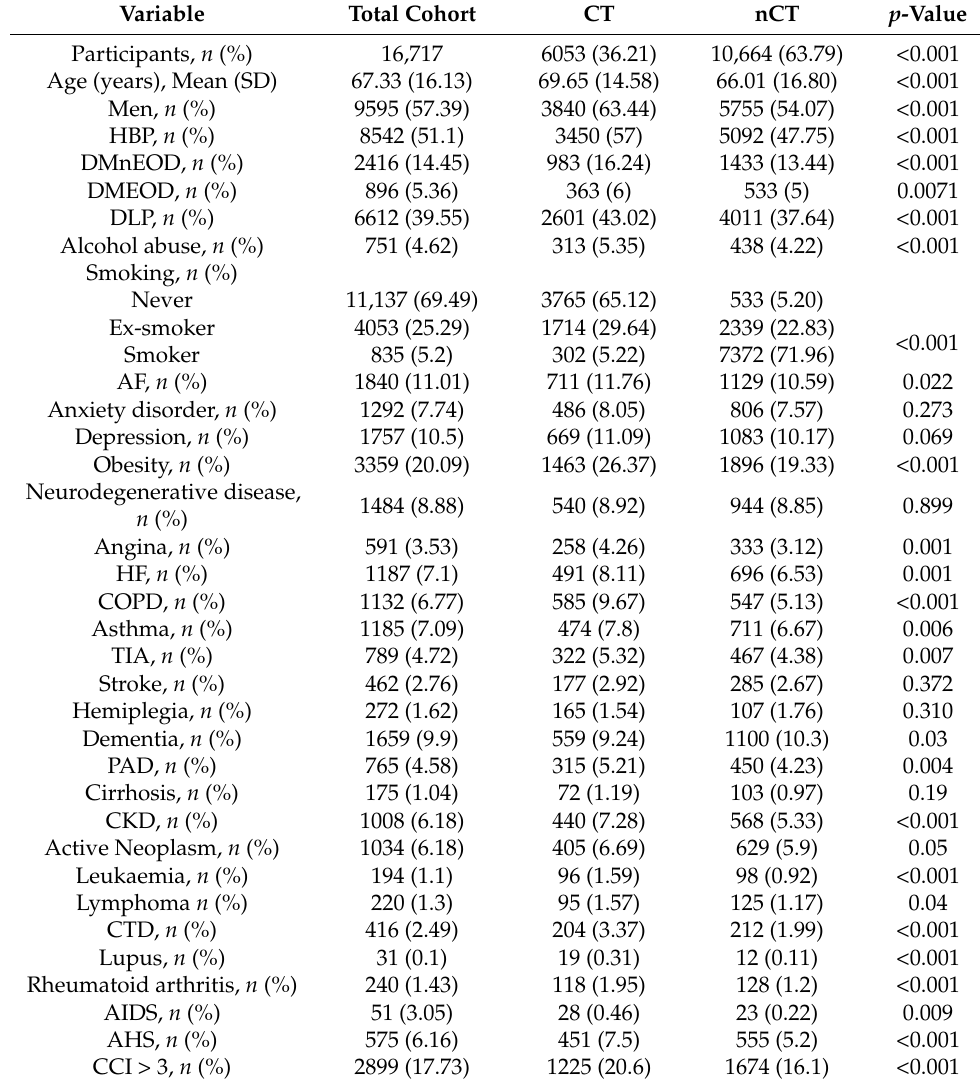
Table 1. Table 1. Basic characteristics and comorbidities in the cohort.